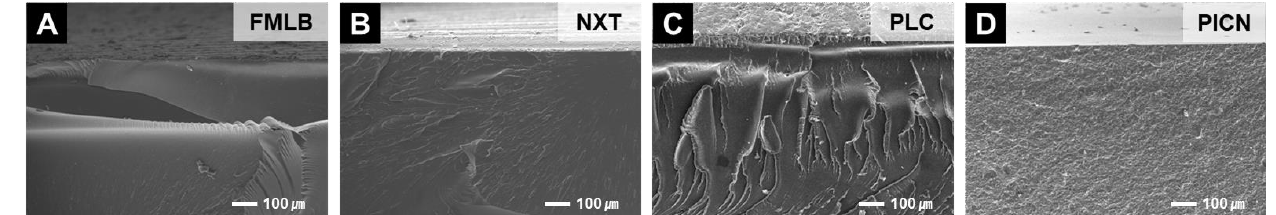
Figure 11. SEM images of the fracture surface of broken specimens after their flexural strength tests at 100-times magnifi- cation. Different fracture surface shapes appeared depending on the material properties. A cleaner fracture surface was observed on the relatively brittle PICN specimen when compared with the FMLB and NXT specimens. Fatigue crack lines were often observed at the fracture surface of PLC samples with high elasticity. ( A ) FMLB, ( B ) NXT, ( C ) PLC, and ( D ) PICN.